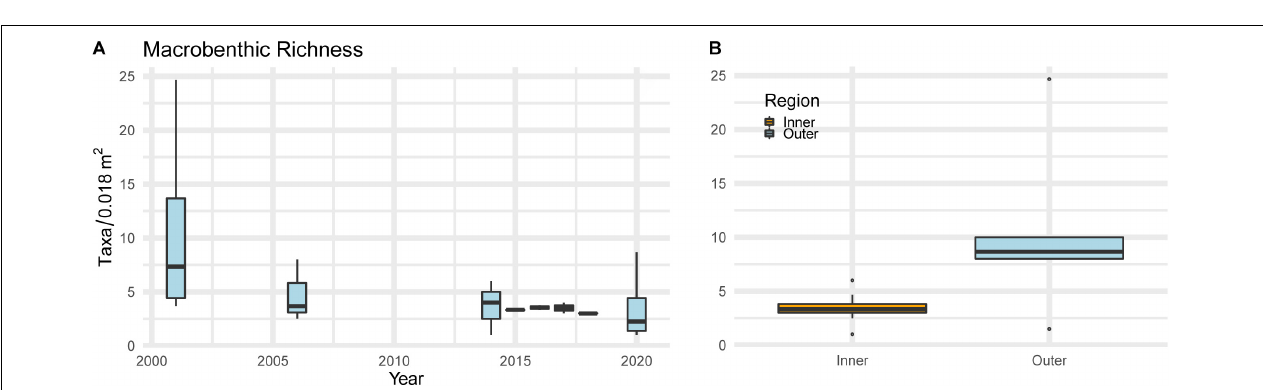
FIGURE 4 | Interannual variability (2001–2020) of macrobenthic species richness (A) and within inner and outer areas (B) of the Bay of Santa Catarina Island during the summer seasons.